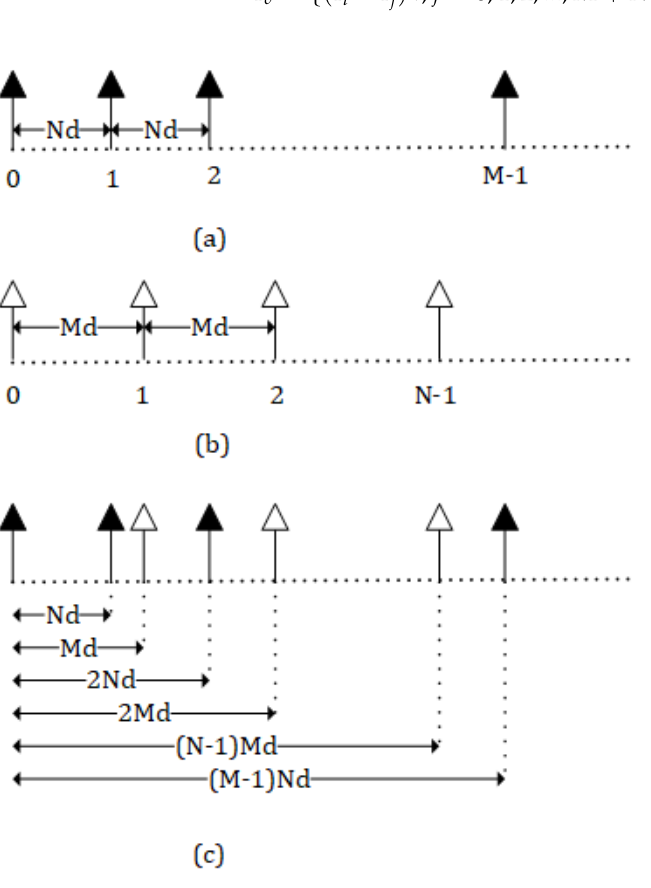
Figure 1. Coprime antenna array configuration: ( a ) sub antenna array 1; ( b ) sub antenna array 2; ( c ) generalize coprime antenna